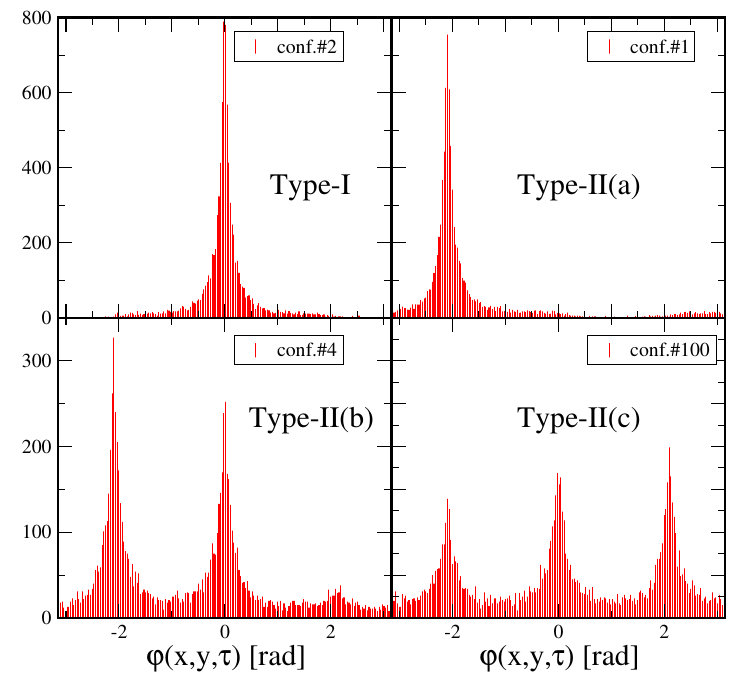
Figure 8 . Histograms of ’ ( x; y; (cid:28) ) for typical con(cid:12)gurations, which are classi(cid:12)ed by the local charge ( q ( (cid:28) )). The corresponding data of the local charge are shown in (cid:12)gure 4.